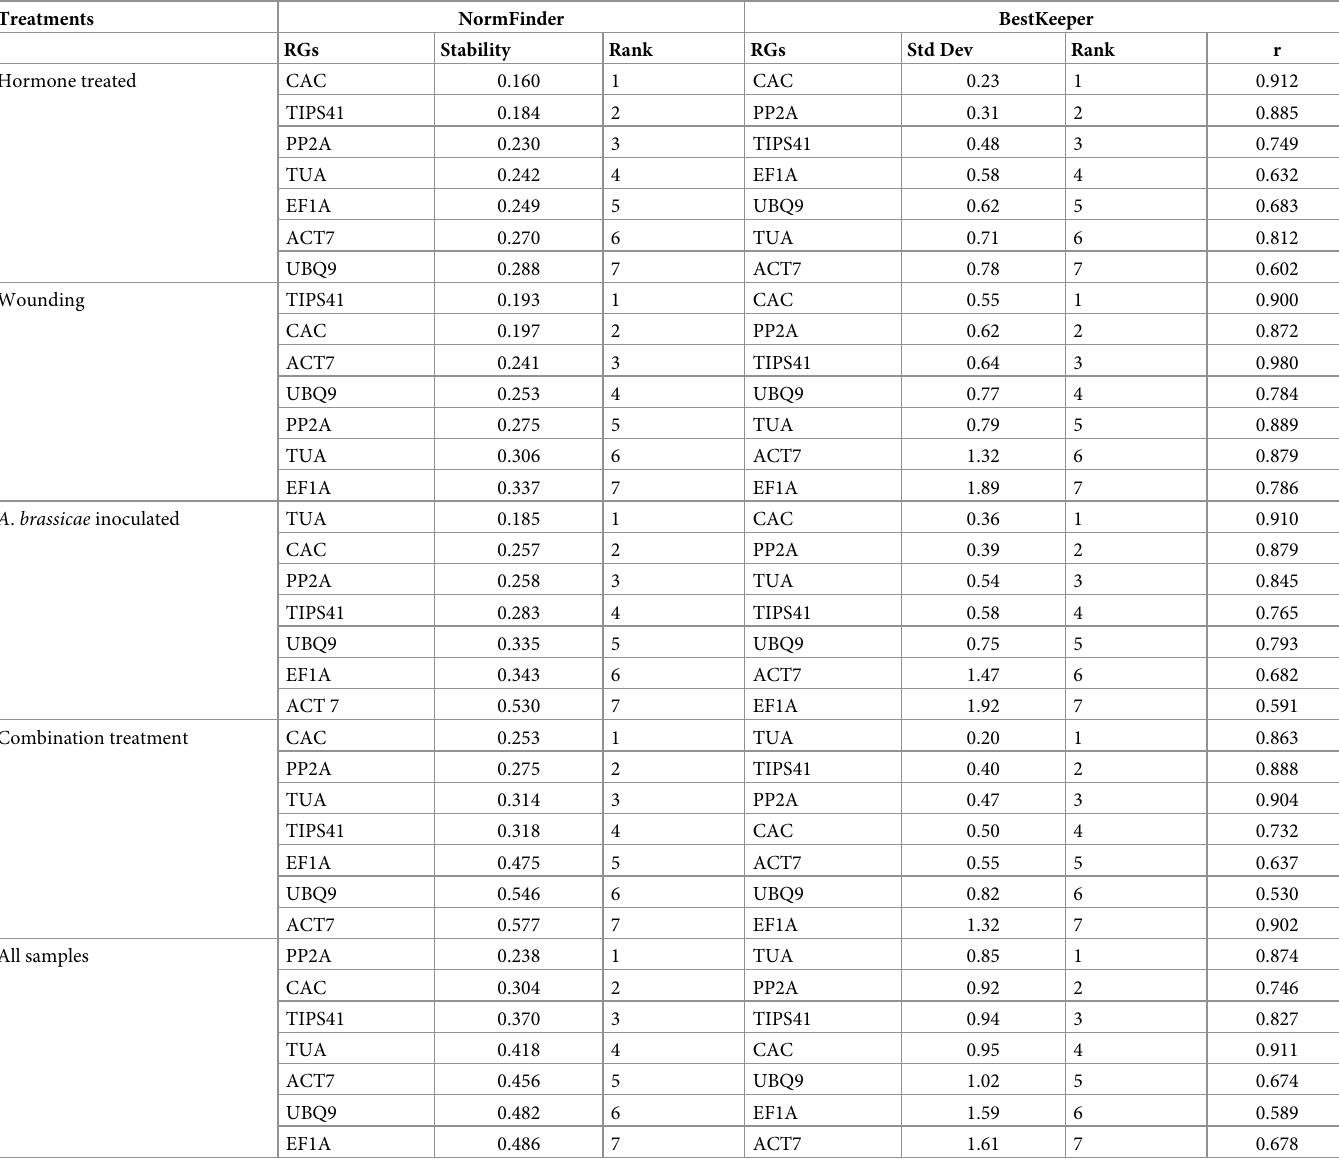
Table 3. Expression stability and ranking of RGs in C . sativa under different experimental conditions identified by Normfinder and BestKeeper